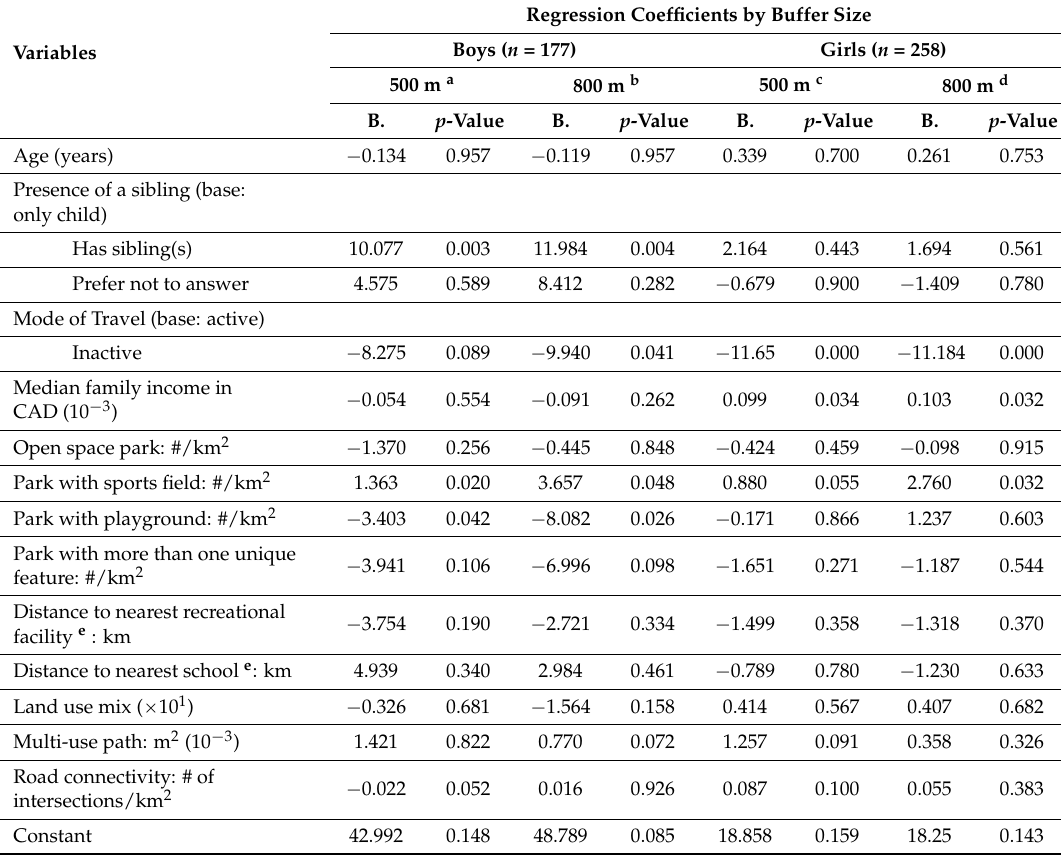
Table 5. Results of sex-stratified models assessing environment characteristics by buffer size and average daily minutes of MVPA outside of school hours during